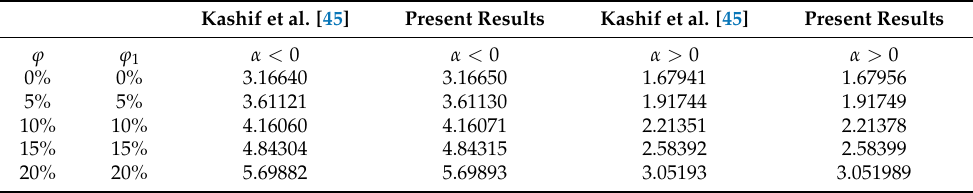
Table 3. Comparison of results regarding the heat transfer rate at the lower disk for Re = 0, ϕ 2 = 0, M = 0.